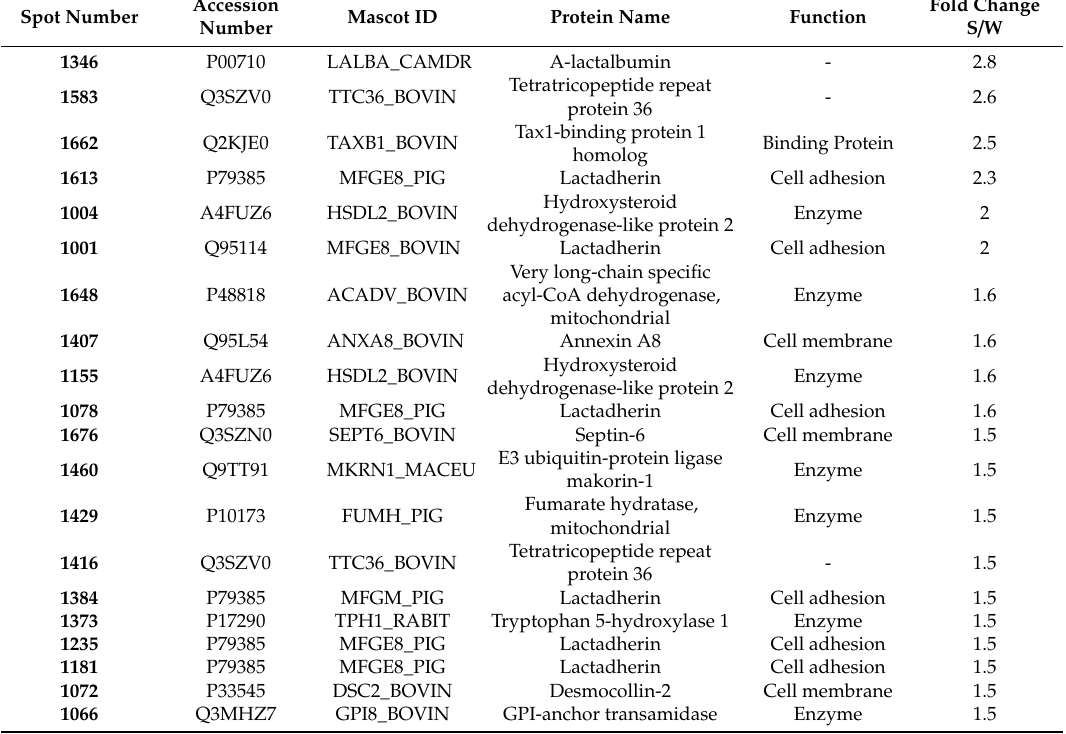
Table 1. Identified proteins with changes in abundance between MFGM-Safra and Wadha breed samples. The average ratio values along with their corresponding levels of fold changes and one-way ANOVA ( p < 0.05) using 2D-DIGE. (Analysis type: MALDI-TOF; database: SwissProt; taxonomy: Other